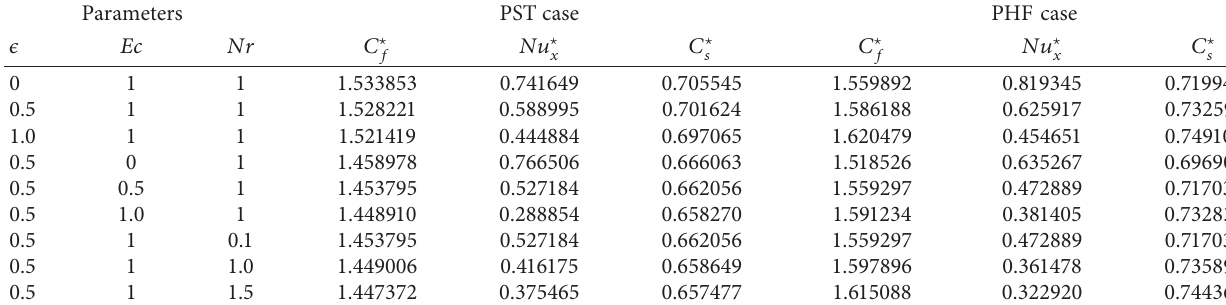
Nu ⋆ C ⋆ C ⋆ x , and s s for variations in ϵ f ,